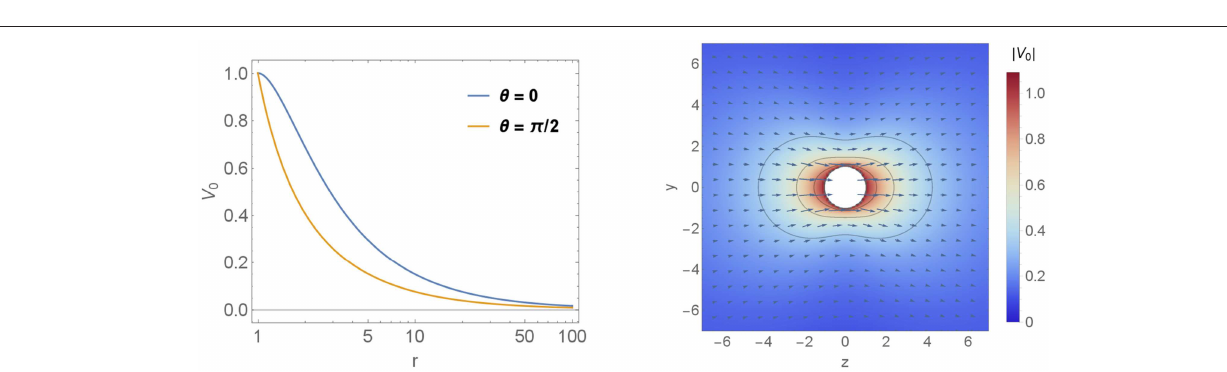
FIGURE 6 | Velocity profiles. The leading order velocity field is shown in two plots. The first one is a semi-logarithmic plot which gives information about the long ranged velocity field v 0 decay parallel to the symmetry axis. Therefore we calculated v 0 along the lines θ = 0 and θ = π/ 2. The second one is a vector-density-plot which indicates the absolute value of | v 0 | and the arrows give additional information about the direction of the velocity field. The particle is denoted by the white sphere in the middle of the plot and it is moving to the right parallel to e z